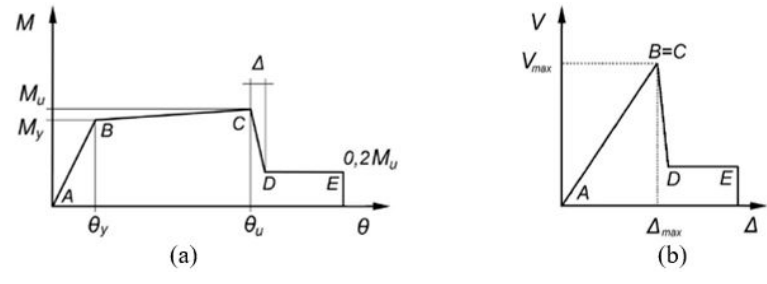
Figure 4. ( a ) Ductile mechanism; ( b ) and brittle mechanism.